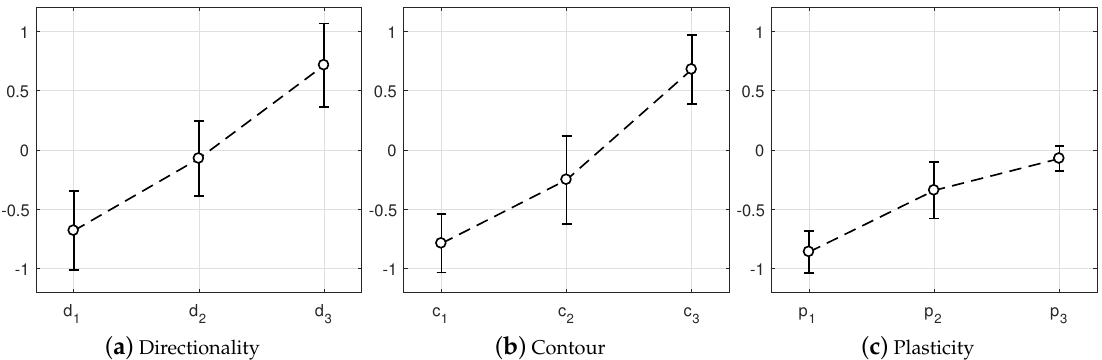
Figure 3. Results of experiment 1: mean values and 95% confidence intervals of perceived strength of sculuptural quality